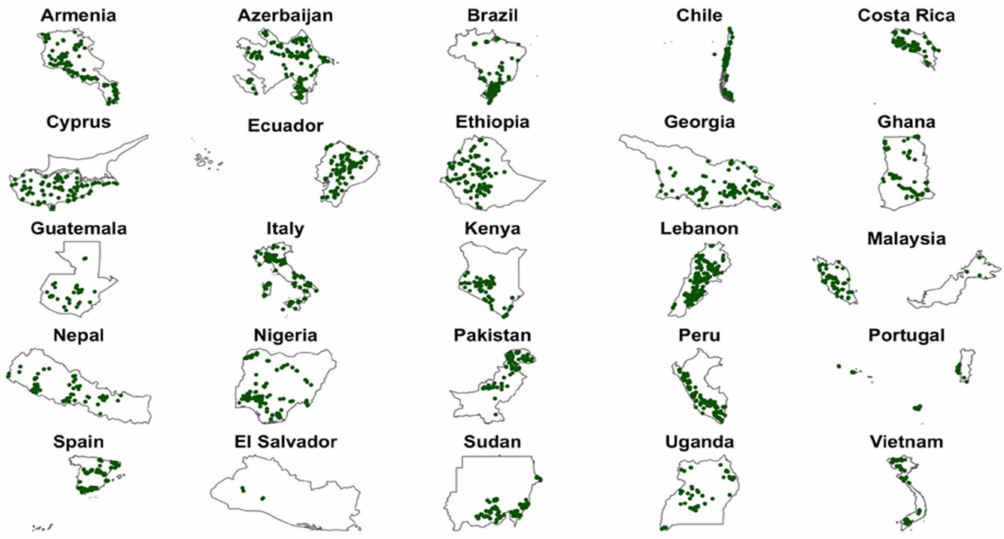
Figure 1. Distribution of unique seed samples collected in the Adapting Agriculture to Climate Change Project (CWR Project). Green dots represent collections made during 2013–2018 in partner countries. The country maps are not to